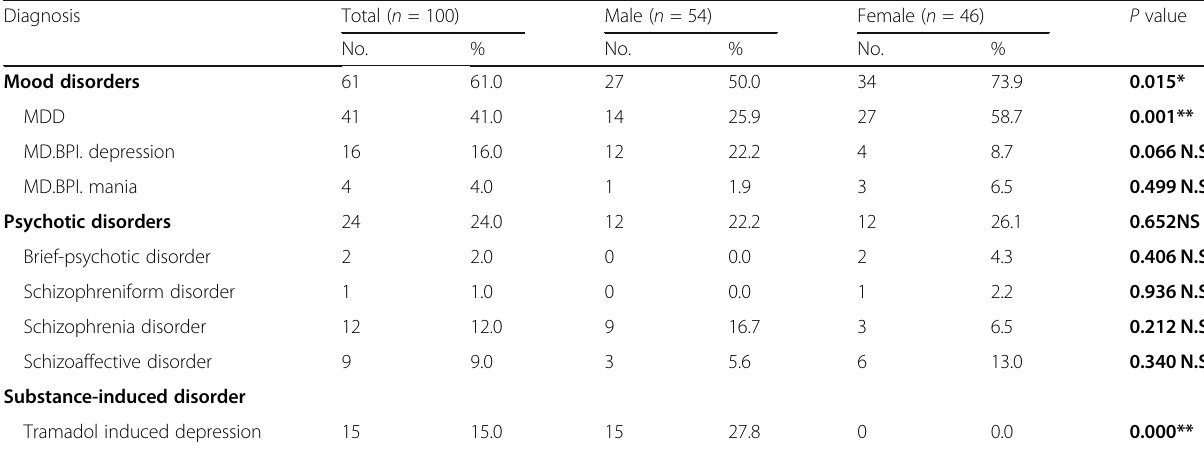
Table 2 Psychiatric diagnoses among the studied sample Diagnosis